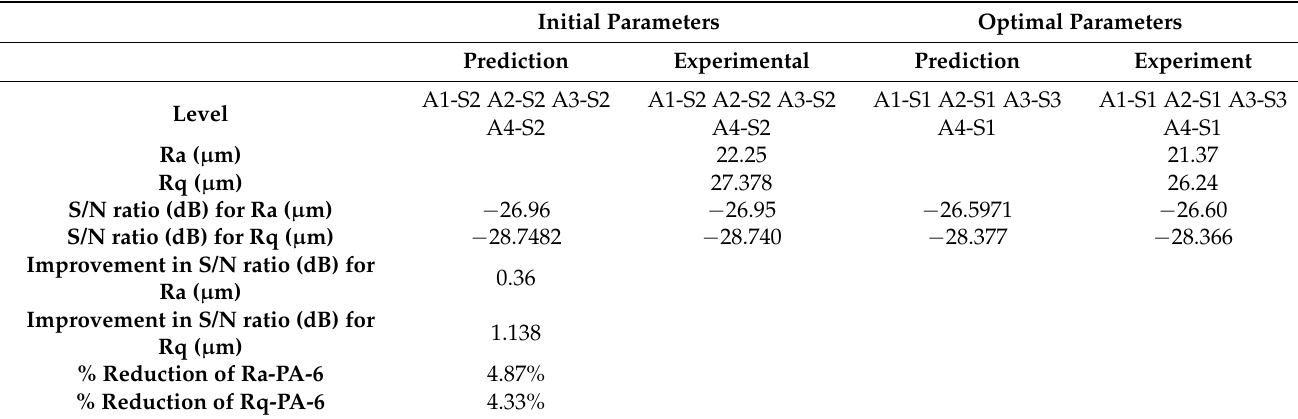
Table A6. The Confirmation test outcomes for Ra-PA-6 and Rq-PA-6